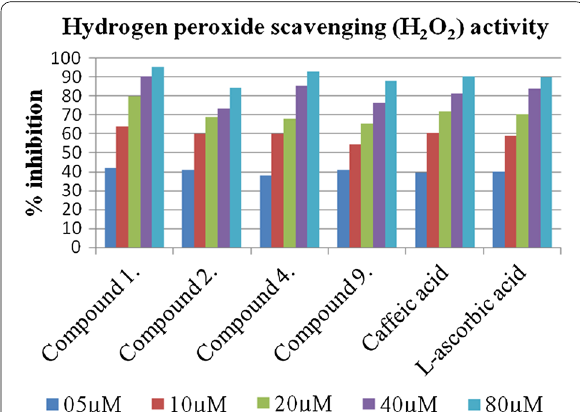
Fig. 7 Hydrogen peroxide scavenging (H 2 O 2 ) activity of most active compounds with respect to reference l -ascorbic